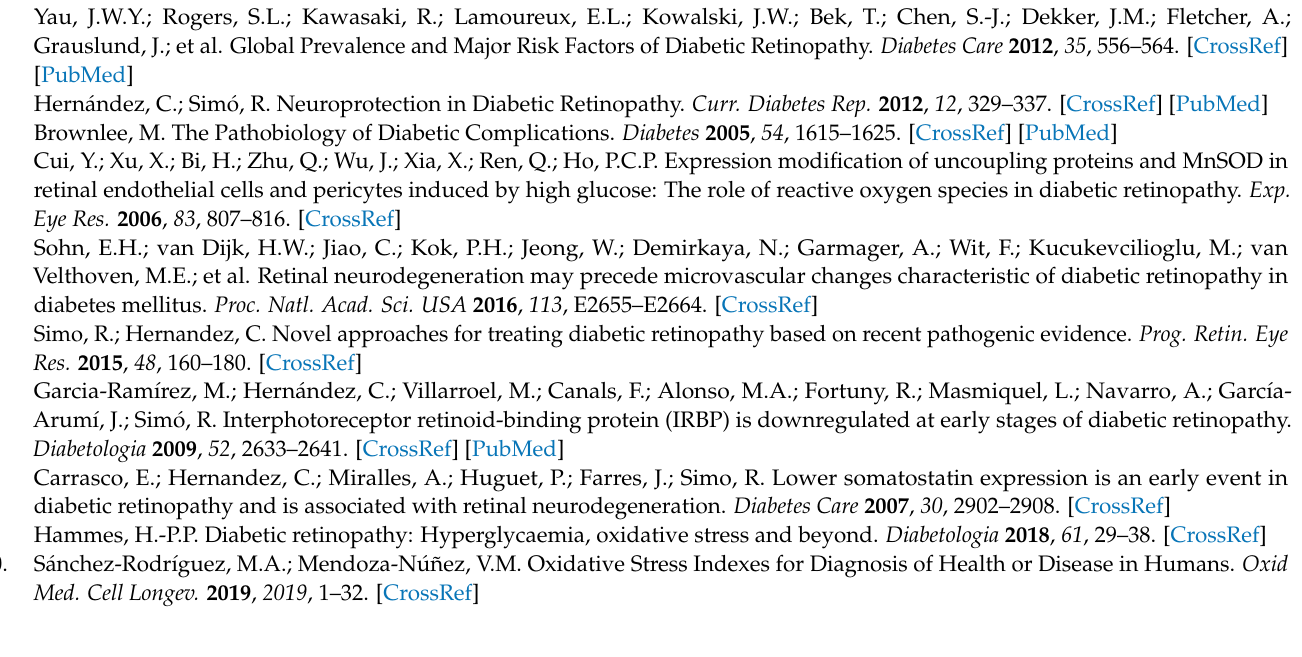
GFP. Results are representative of three retinal explants per condition. Table S1: PCR